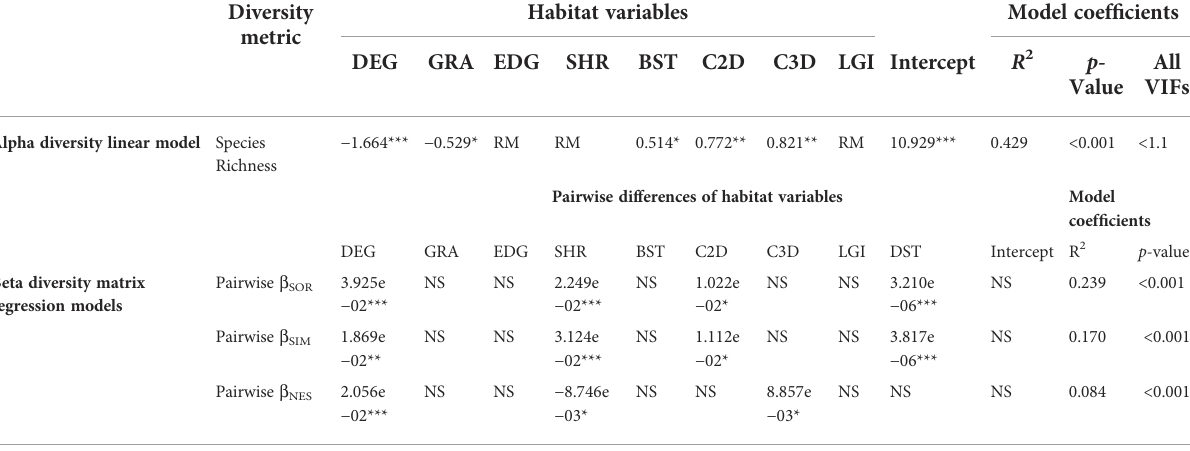
TABLE 2 Standardized estimates of linear models and matrix regression models between habitat variables with alpha and beta diversity metrics based on 126 bird assemblages in Nyanpo Yutse. Diversity